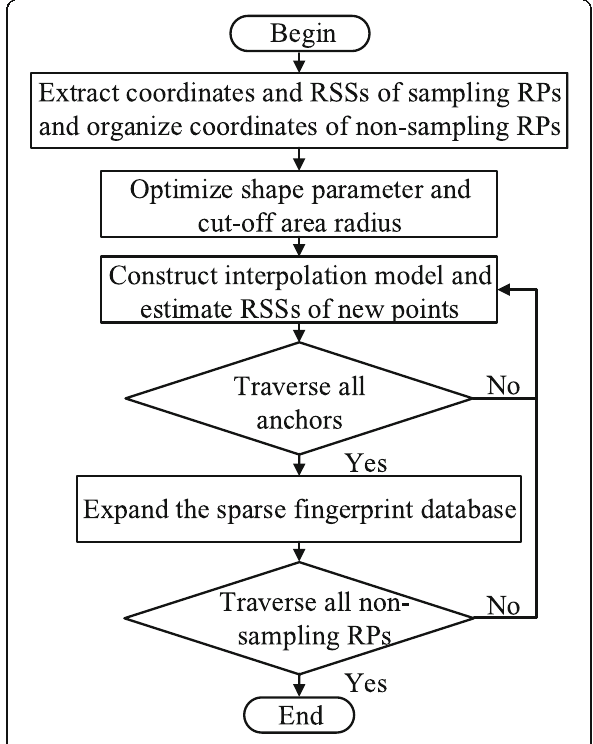
Fig. 5 Flowchart of the interpolation